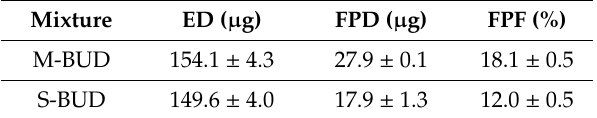
Table 5. In Vitro deposition tests—ED, FPD, and FPF of budesonide (BUD) from binary